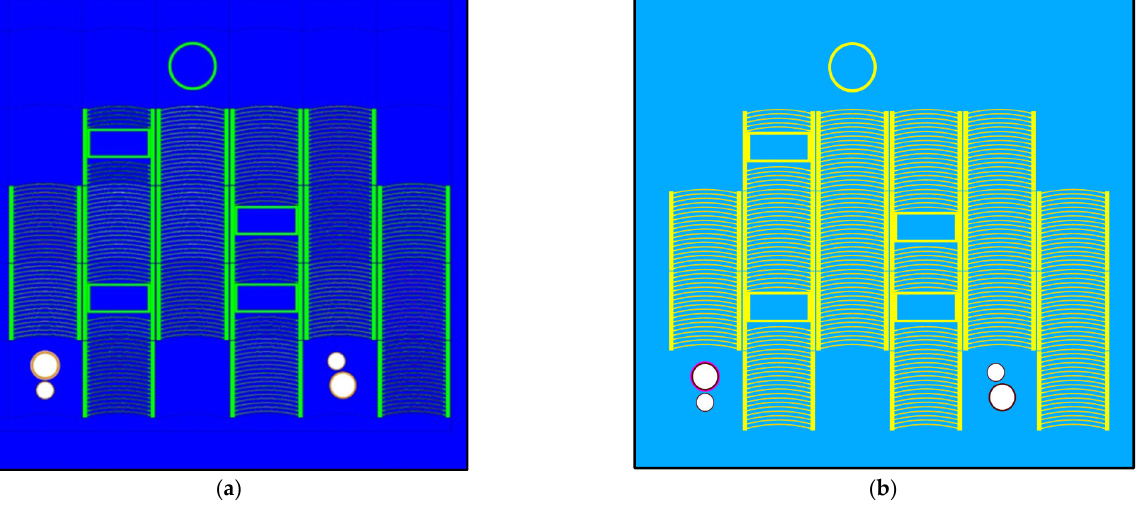
Figure 4. XY top-view horizontal cross-section of the MSTR core as modeled in ( a ) MCNP5 and ( b ) OpenMC. Figure 4a is taken from [12]. ( b ) OpenMC. ( a ) is taken from